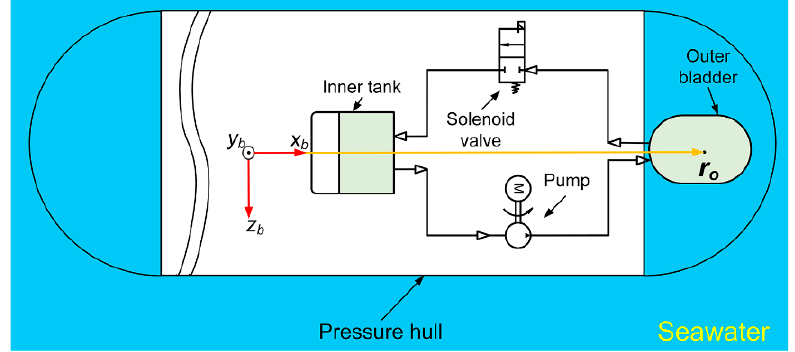
Figure 5. Schematic diagram of the variable buoyancy system.